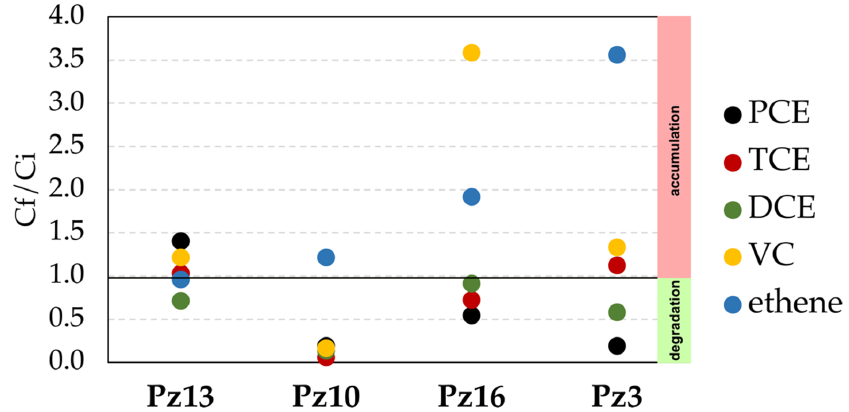
Figure 4. In situ CE degradation by means of ratio between final and initial concentration of CE in the groundwater sampled from piezometers Pz13, Pz10, Pz16 and Pz3. 3.5. Field Monitoring of Microbial Populations Involved in OHR At time zero in all the four piezometers, total bacterial and archaeal 16S rRNA genes ranged from 10 8 to 10 11 and from 10 2 to 10 7 gene copies L − 1 , respectively (Figure S3). Mem- bers of the family Geobacteraceae and Dehalococcoides accounted for 10 2 to 10 6 copies of 16S rRNA genes L − 1 . Genes involved in the reductive dehalogenation of TCE and DCE ( tceA ) and of VC ( vcrA ) varied between 10 4 to 10 7 copies L − 1 , with tceA being more abundant than vcrA (Figure 5). After a 20 month-treatment, Bacteria increased significantly only in Pz13 while, Ar- chaea increased significantly of one-two order of magnitude in all piezometers. Geobacter- aceae and Dehalococcoides increased mostly in the downstream injection wells (Pz10 and Pz3). In both transects, tceA and vcrA increased from 10 5 to 10 6 gene copies L − 1 in the pie- zometers downstream the permeable reactive bio-barrier (Pz10 and Pz3). The difference of OHR marker genes between upstream and downstream piezometers was higher in transect Pz13-Pz10, compared to transect Pz16-Pz3 (Figure 5).